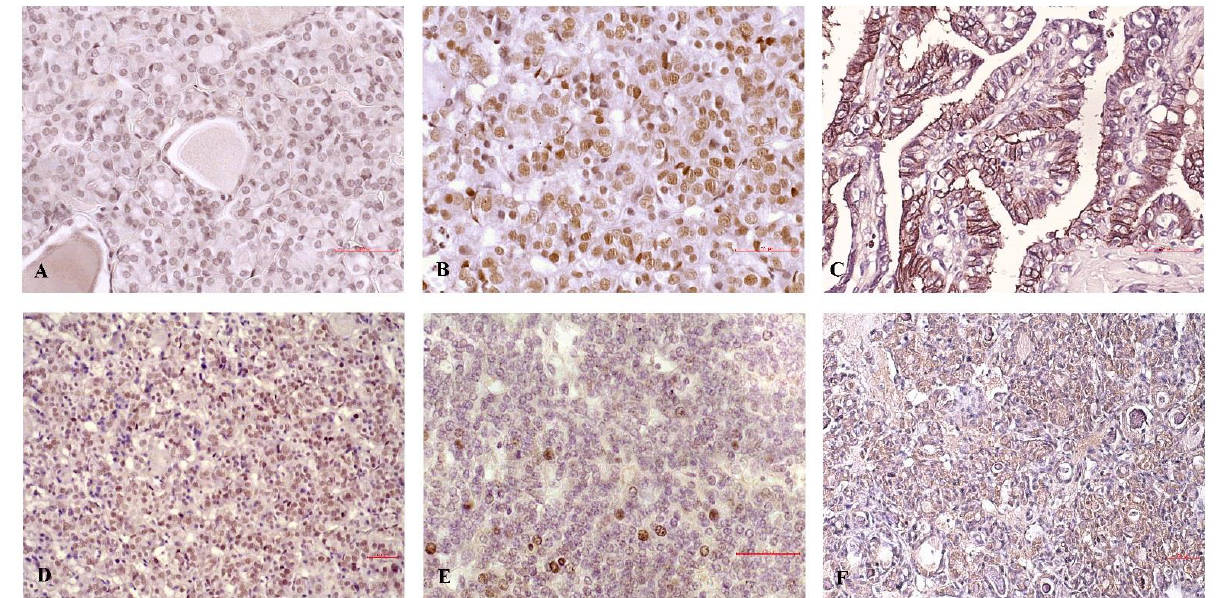
Figure 4. Micrograph illustrating the expression of c-Jun, acetylated c-Jun, and MMP-9 in representative PTC samples. The upper row of the micrograph represents cases with extra-thyroid invasion, showing: ( A ) weak widespread staining of c-Jun (low expression group), ( B ) strong diffuse staining of acetylated c-Jun in most tumor cells (high expression group), and ( C ) strong diffuse staining of MMP-9 in most tumor cells (high expression group). The lower row presents indolent cases of PTC, showing: ( D ) moderate staining of c-Jun in more than 40% of tumor cells (high expression group), ( E ) focal (up to 40% of tumor cells) staining of acetylated c-Jun (low expression group), and ( F ) weak widespread staining of MMP-9 (low expression group). Scale bars represent 50 µm.